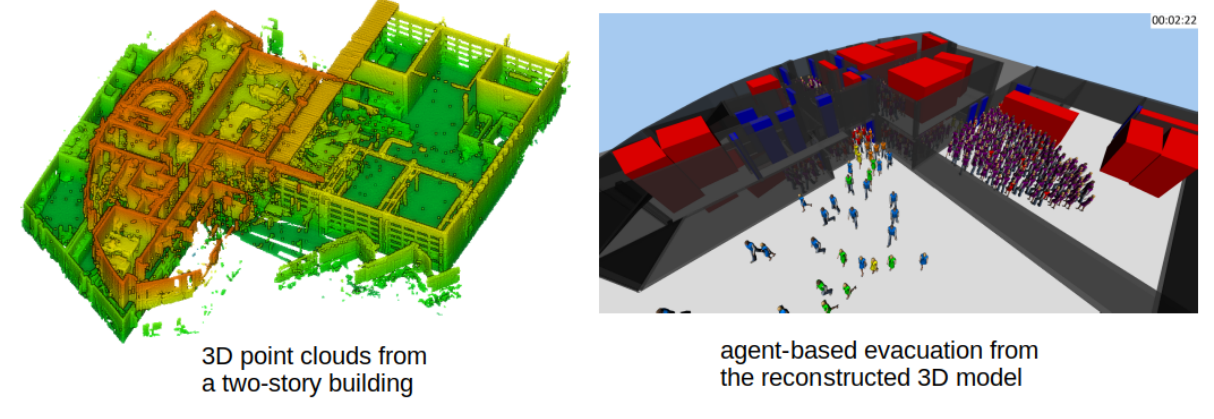
Figure 1: (a) Perspective view of the 3D point cloud of a building with two floors from which we compute (b) a reconstructed sandbox model that we use in agent-based simulation.